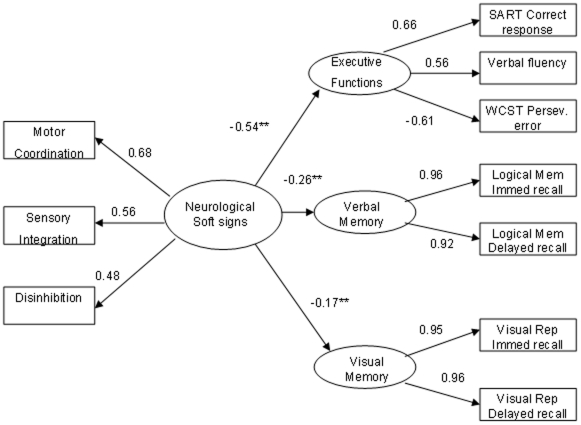
The structure model of the influence of Soft Sign on cognitive function in healthy controls.χ2 (29) = 47.79, p = 0.015, NFI = 0.93, NNFI = 0.95, CFI = 0.97, IFI = 0.97, RMSEA = 0.064. Note. * p<0.05, ** p<0.01.